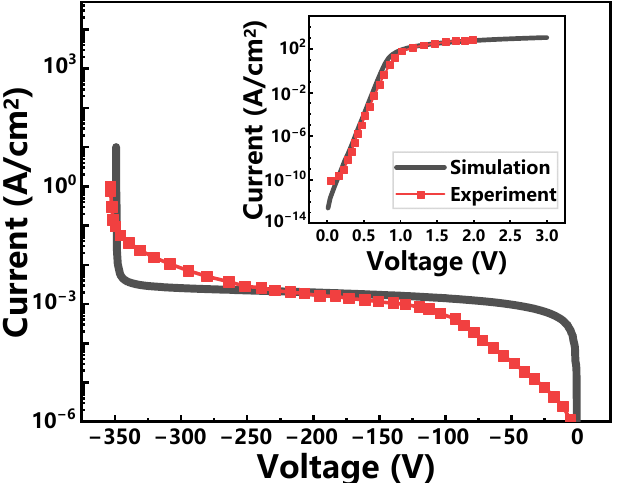
Figure 2. Forward bias (inset) and reverse breakdown comparison of the simulated and experimental data. Adapted from [29].